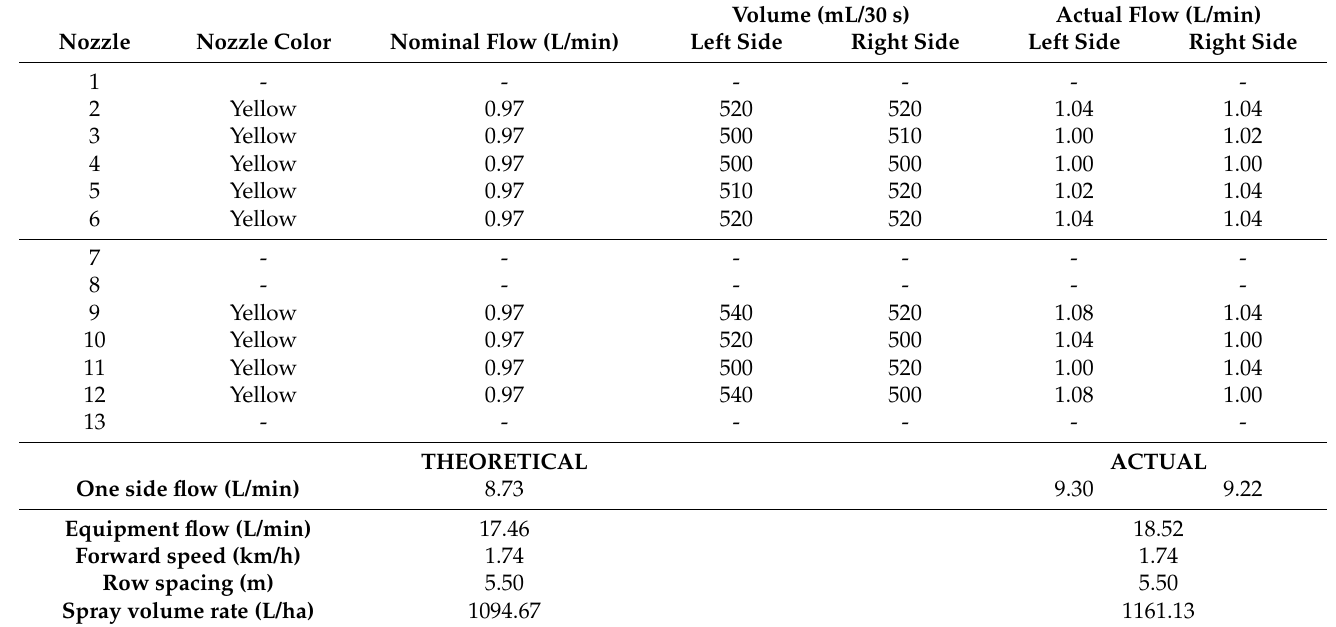
Table A9. Selection and calibration of nozzles for the C2 sprayer, with the following configuration: Adjusted to the vegetation/High & Low fan speed/Low spray volume rate/Conventional nozzles (Fine)/Pressure: 9 bar.